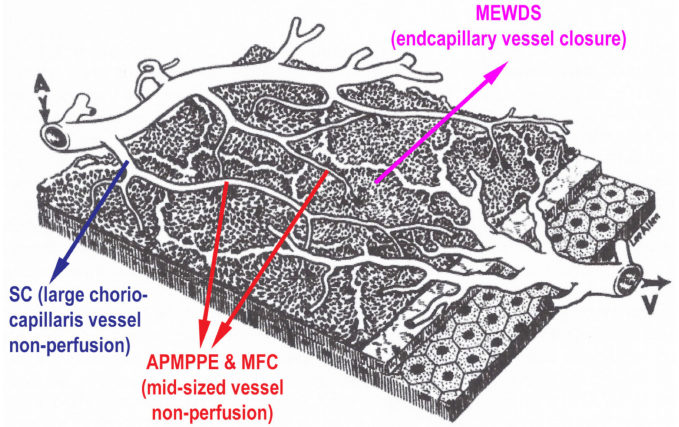
Figure 5. Clinicopathology of PICCPs according to vessel location of non-perfusion. Schematic draw- ing of the different levels of choriocapillaris vessels, the occlusions of which determine the type of choriocapillaritis. (Reproduced from Hayreh SS, Br J Ophthal 1973; 59:631, by permission of the BJO).